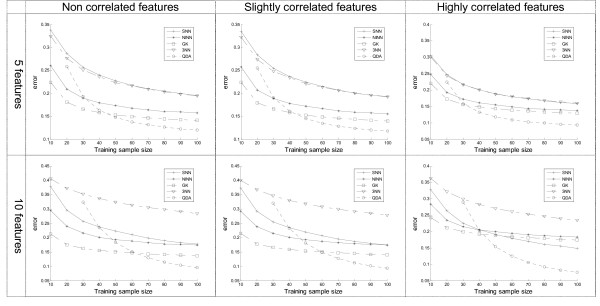
Comparison of various classifiers for high-curvature nonlinear model.